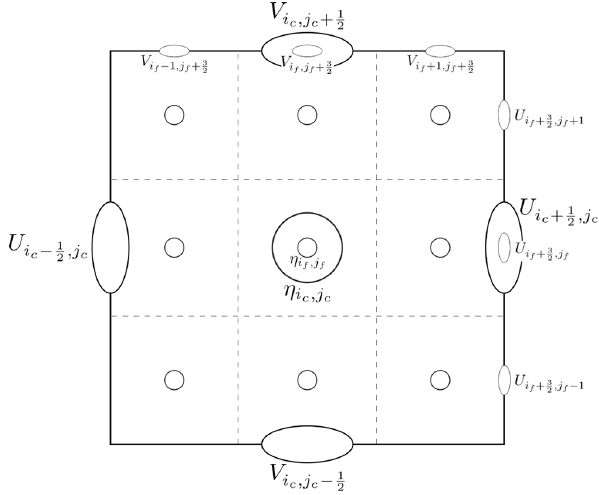
Figure 4. A coarse-grid cell divided into nine fine-grid cells on a C